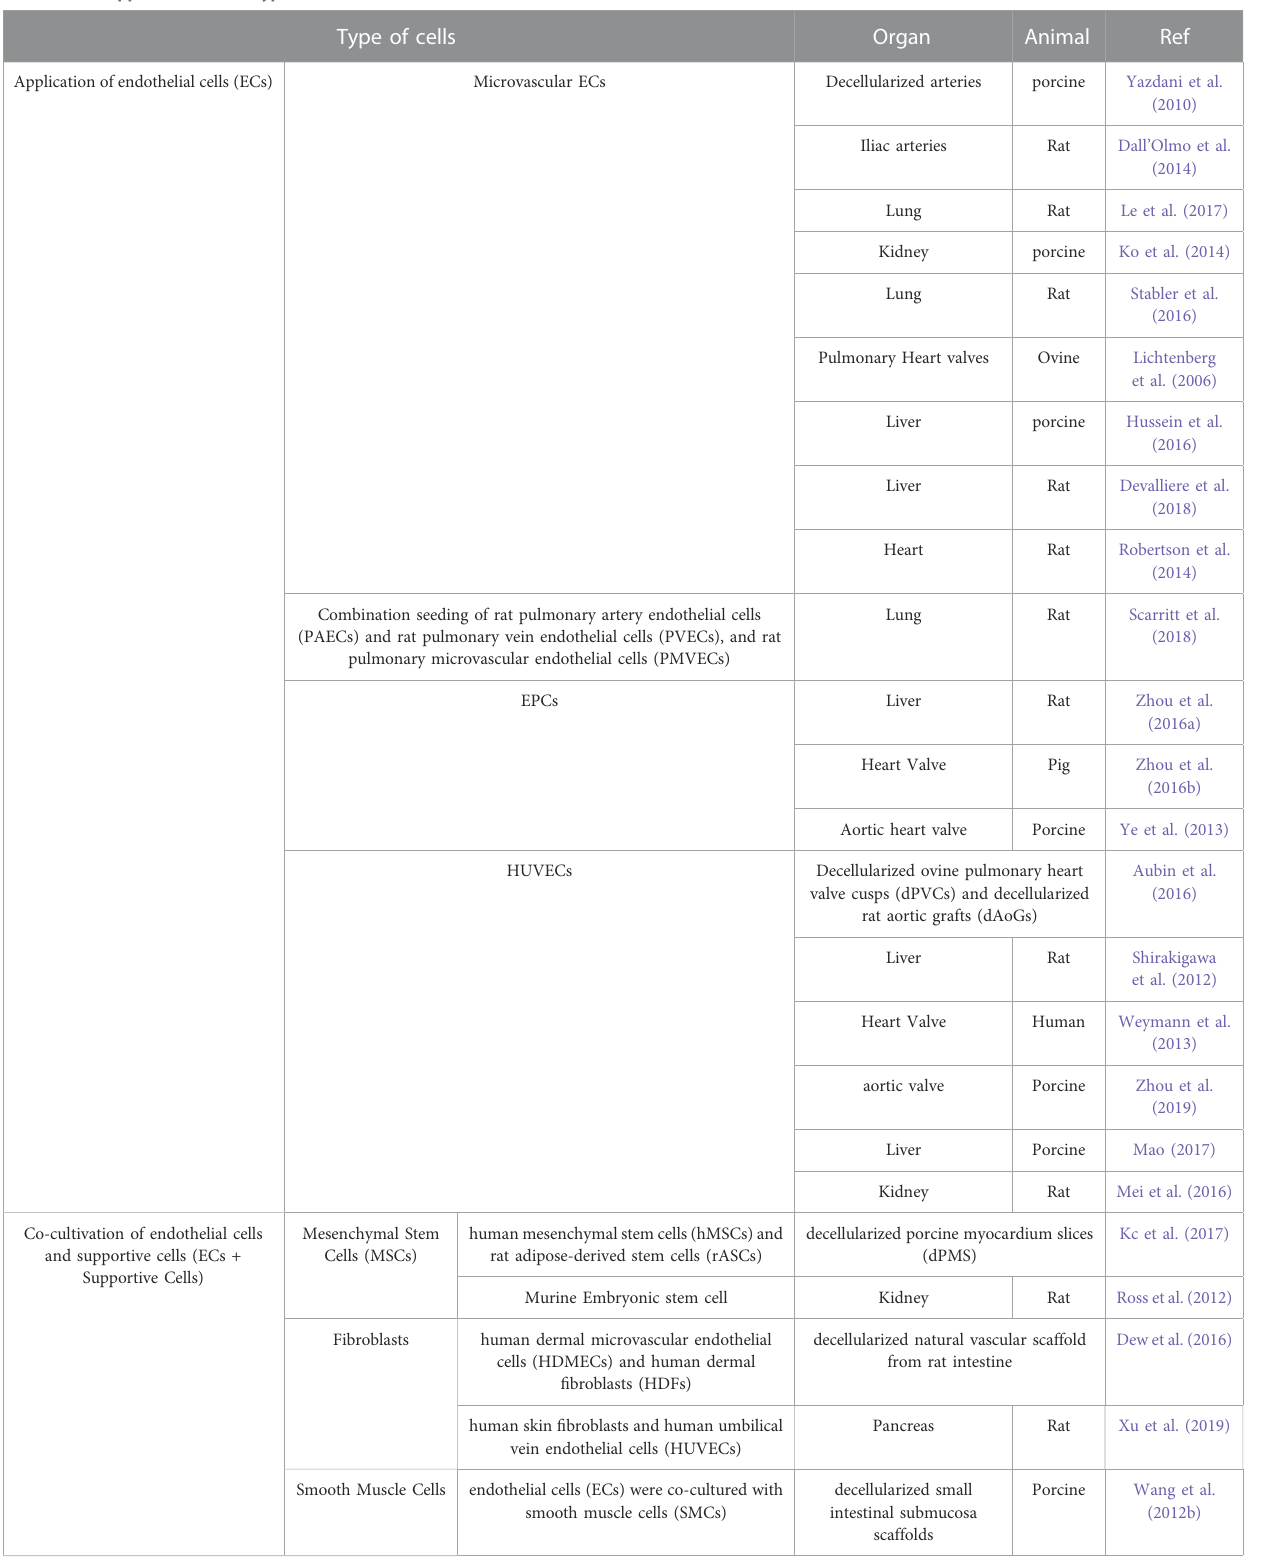
TABLE 1 The application of cell type on